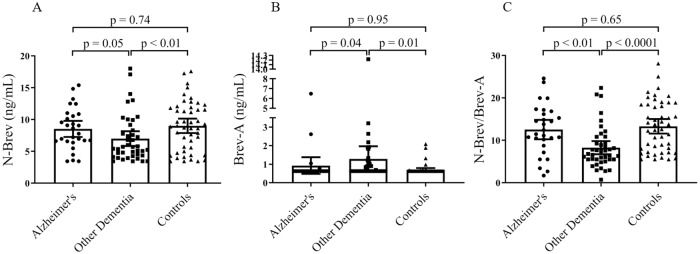
Detection of N-Brev and Brev-A in serum from NDCs and patients diagnosed with AD or ODs.Levels (Mean with 95% CI) of N-Brev (A) and Brev-A (B) measured in N-Brev and Brev-A assays in serum of NDCs and patients diagnosed with AD or ODs are depicted in scatter dot plots. In (C), ratios of N-Brev and Brev-A are depicted. Significance of differences in biomarker levels is determined using Kruskal-Wallis H Test of Mean Ranks adjusted for multiple testing.